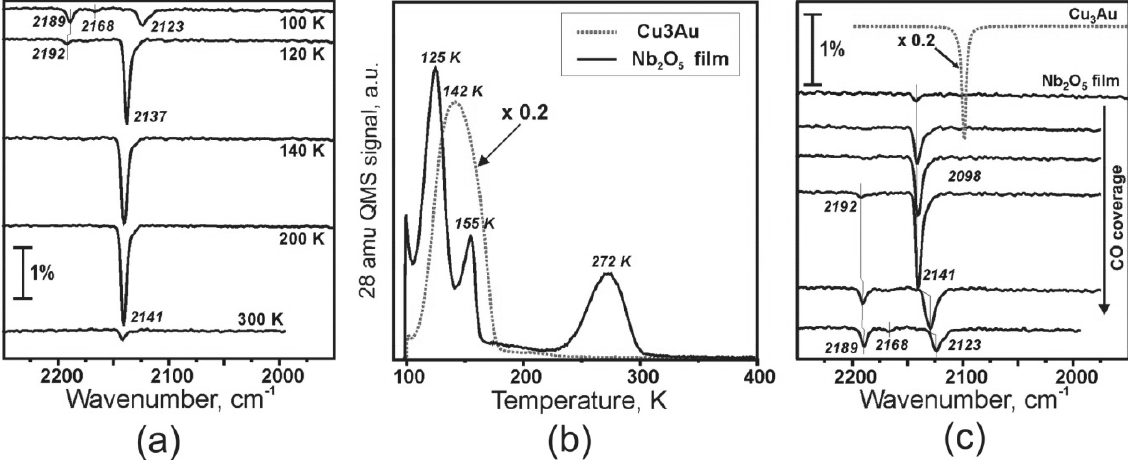
Fig. 10 – (a) Typical TPD spectrum of CO adsorbed on thin niobia films at 100 K. (b) IRAS spectra of CO adsorbed on thin niobia films as a function of CO exposure at 100 K. (c) IRAS spectra of CO adsorbed at 100 K and subsequently flashed to the indicated temperatures. All spectra are recorded at 100 K. The TPD and IRAS spectra for a Cu 3 Au(100) substrate at saturation CO coverage are also shown in (b) and (c), for comparison (Mendes et al. 2006b).